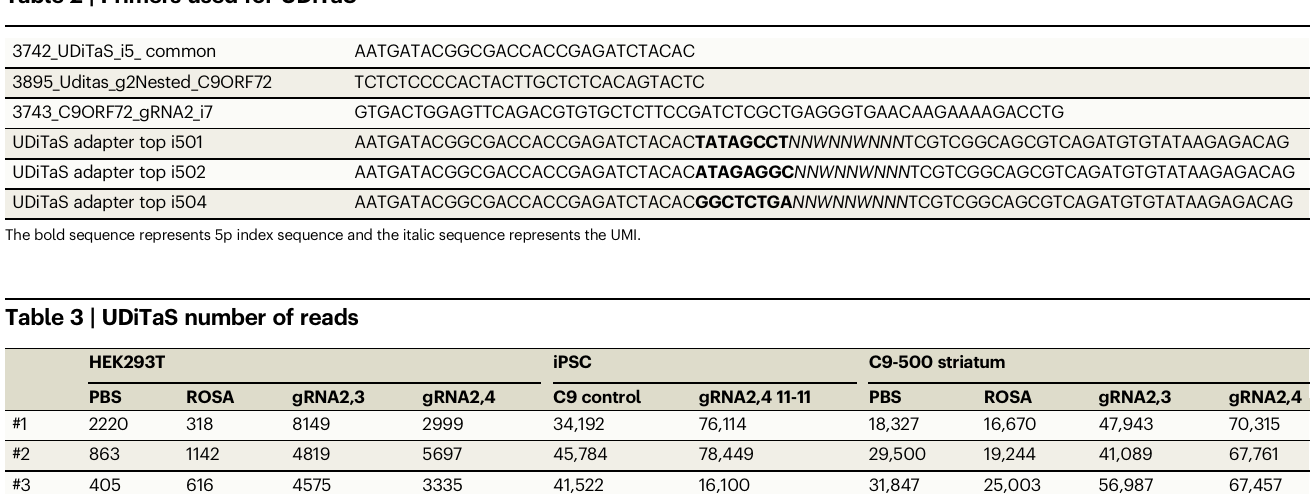
Table 2 | Primers used for